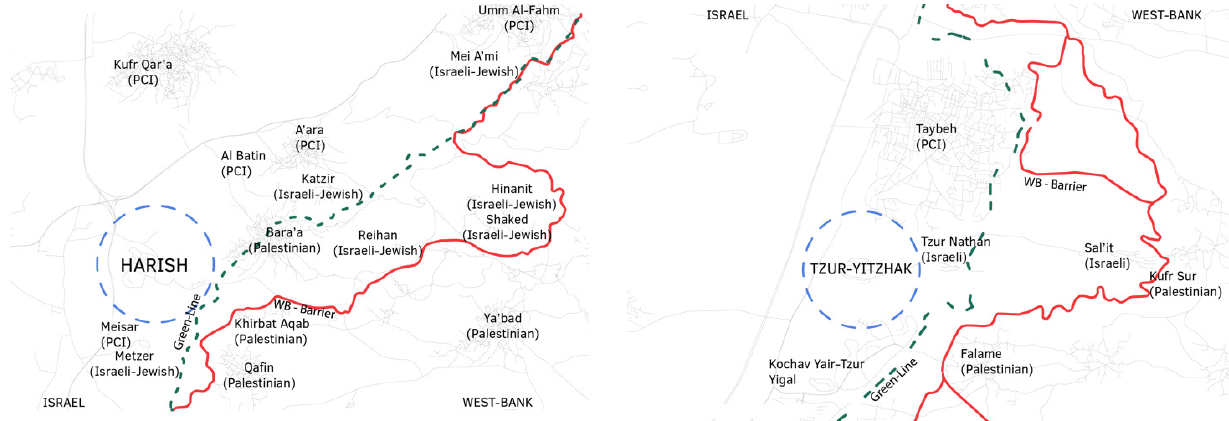
Figure 4. Harish (left) and Tzur‐Yitzhak (right) along the Green Line (green, dashed) and the West Bank Barrier (red) in 2015. Note: PCI—Palestinian citizens of